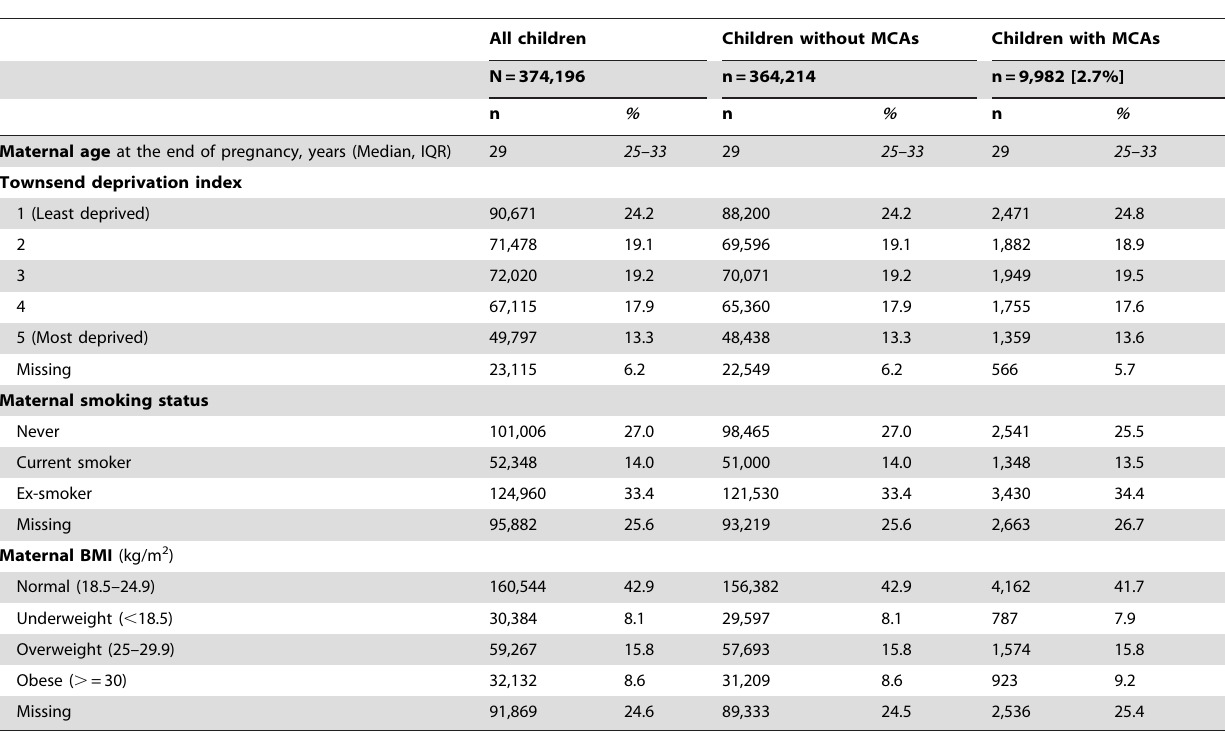
Table 1. Maternal characteristic of children with and without major congenital anomalies.